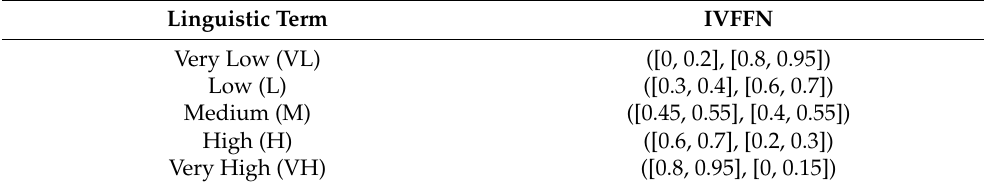
Table 3. Linguistic variables and their corresponding interval-valued Fermatean fuzzy numbers.